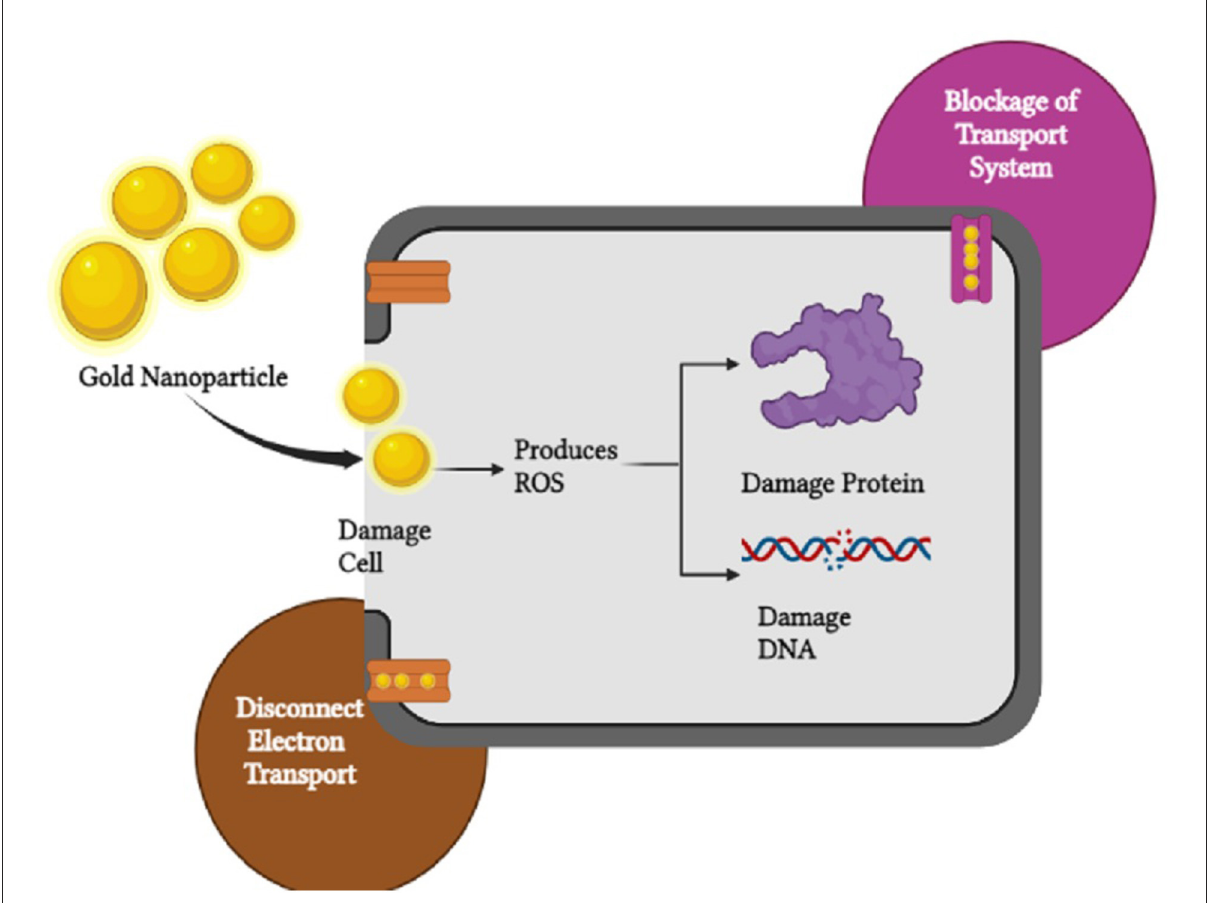
FIGURE2 Action of MNPs on microbial